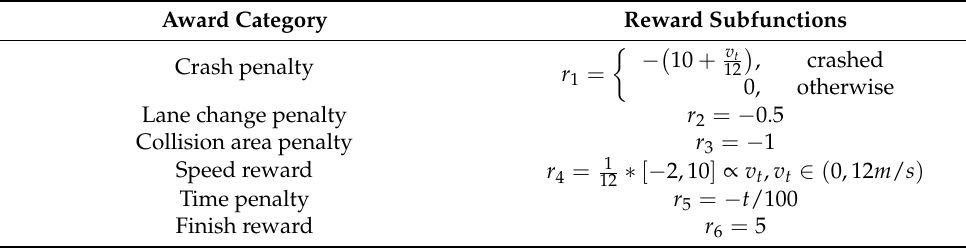
Table 5. IP-SAC reward